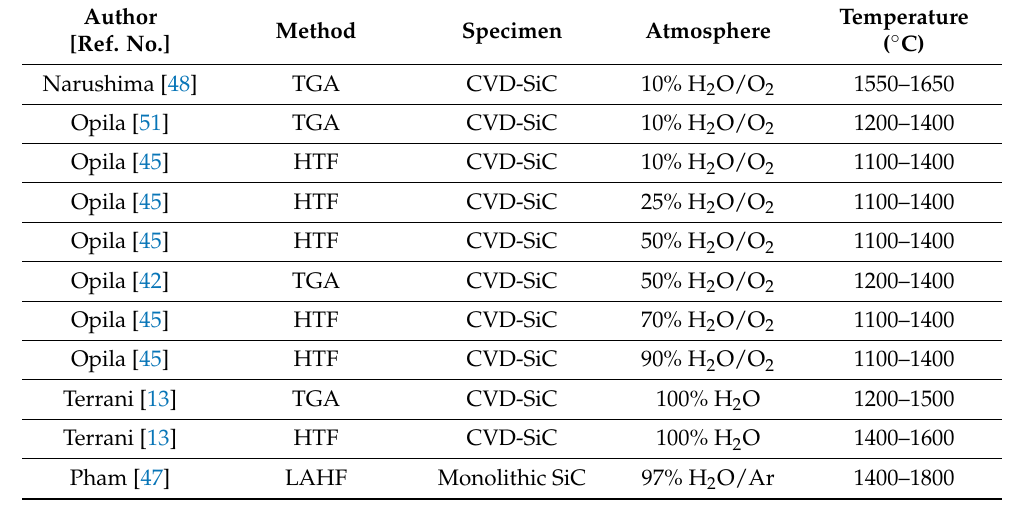
Table 2. Investigation conditions of major studies for oxidation kinetics of SiC in steam.